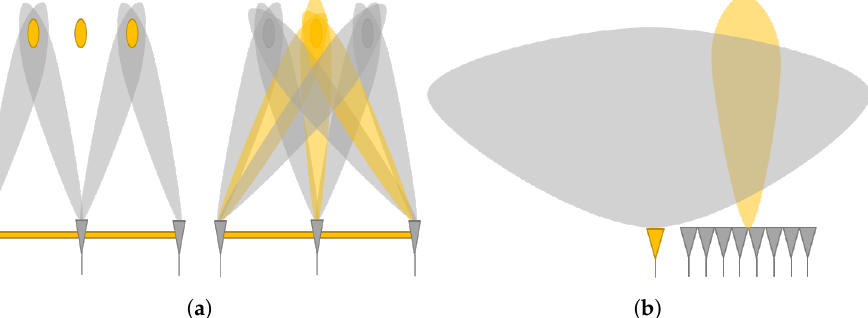
Figure 8. ( a ) Comparison of Spotlight and Strip-Spot modes used in the experiment; ( b ) emulated Stripmap